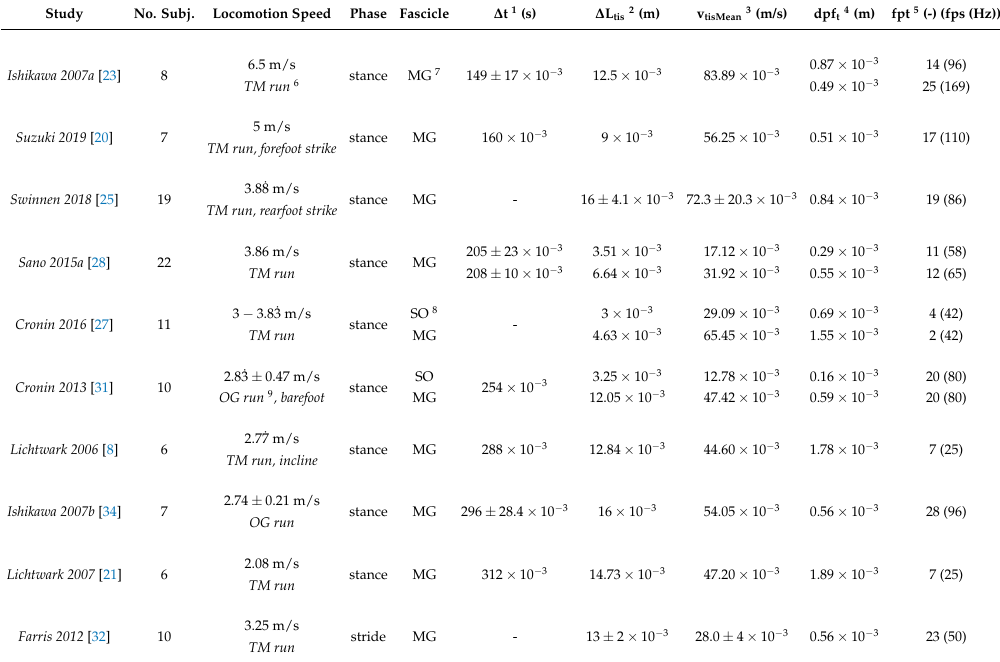
Table 2. Mean fascicle velocities and mean calculated frame-rate-dependent parameters for full stance or stride phases. Note that not all studies examined provided sufficient information (e.g., only statistical values) to extract all parameters for the investigated time